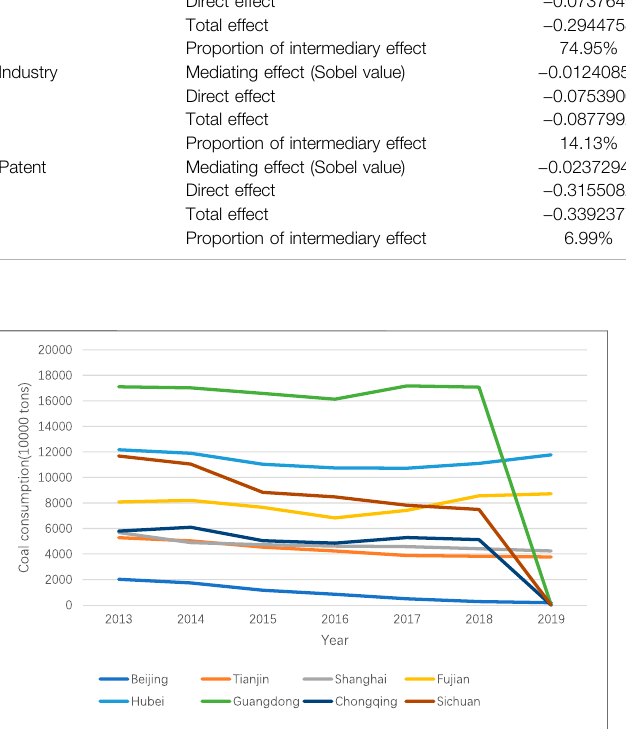
FIGURE 3 | Coal consumption in pilot areas after 2013.